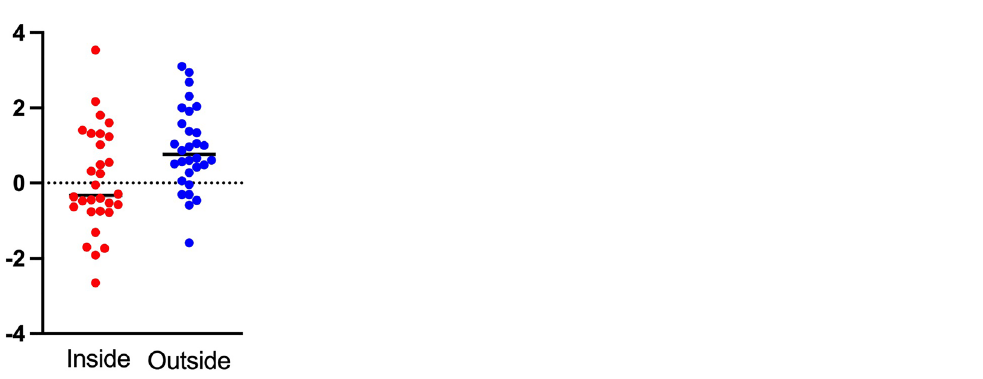
Figure 3. The difference in P300 peak amplitude between the post-test and pre-test for indoor and outdoor walks. Individual data are plotted for each